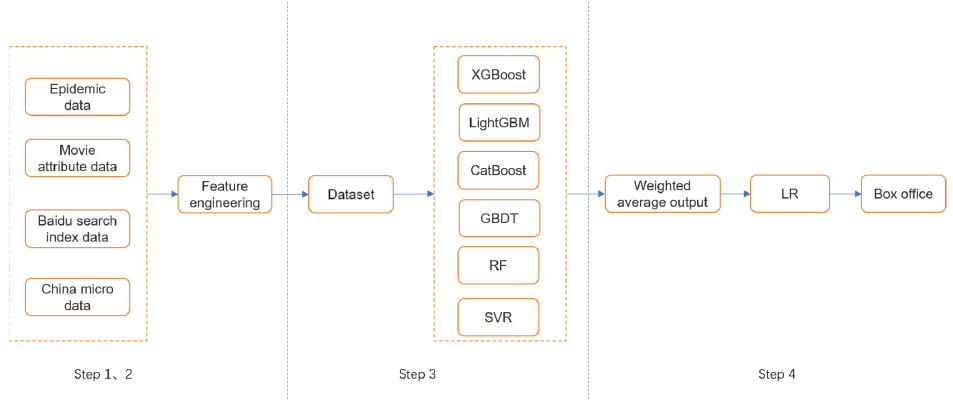
Figure 5. Stacking algorithm architecture diagram.